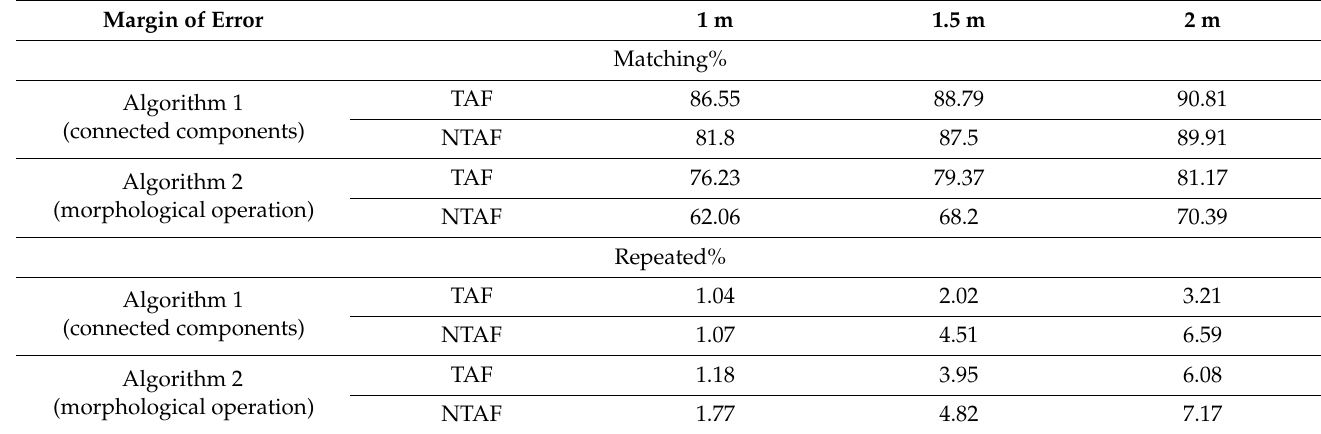
Table 1. Treetop detection validation: Results of the matching percentage and repeated percent-